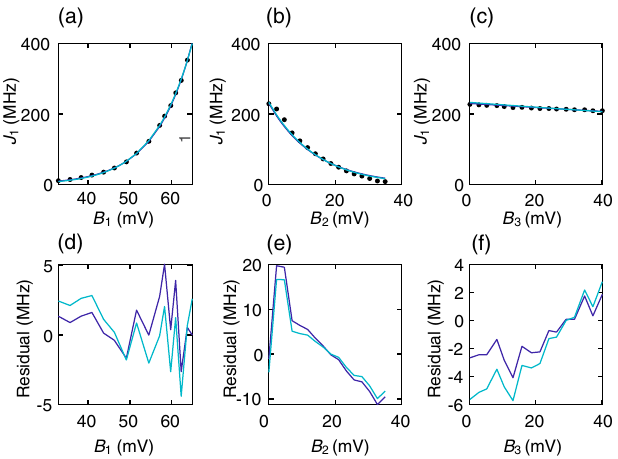
FIG. 3. Dependence of J 1 on the barrier-gate voltages. (a) J 1 vs B J B B ¼ 60 mV. (c) J B B ¼ 60 mV. 1 . (b) 1 vs 2 , for 1 1 vs 3 , for 1 The black data points in each panel are obtained from the fast Fourier transform of a data set similar to Fig. 1(b). In (a) – (c), the dark blue line is the fit to the exponential model, and the light blue line is the fit to the HL model. Panels (d) – (f) show the difference between the fits and the data for the two